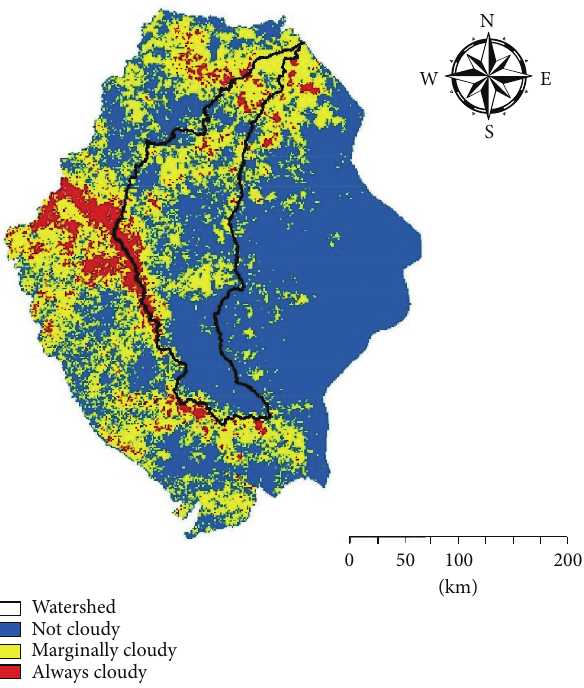
Figure 7: Cloud average distribution map over the southern part of KSA.